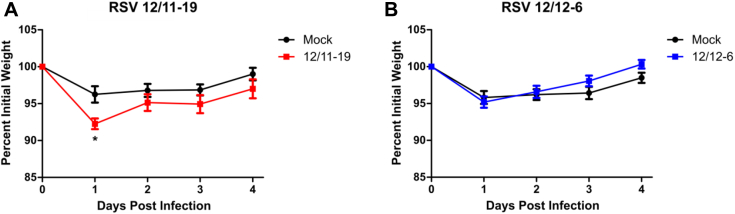
RSV-induced weight loss with 2012 clinical isolates. WT mice were infected with RSV strains 12/11-19 (1.0 × 106 PFU; A) or 12/12-6 (9.0 × 105 PFU; B), and weight loss was measured daily for 4 days. Data are displayed as a percentage of initial body weight and represent means ± SEMs. For Fig E9, A-B, n = 8-10 mice per group from 2 independent experiments. *P < .05, 2-way ANOVA.